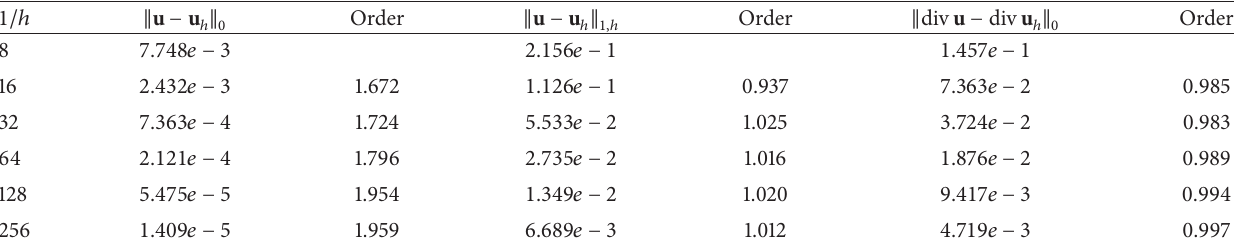
Table 3: 𝜇 − = 1 , 𝜇 + = 10 , and 𝜆 = 100 𝜇 .